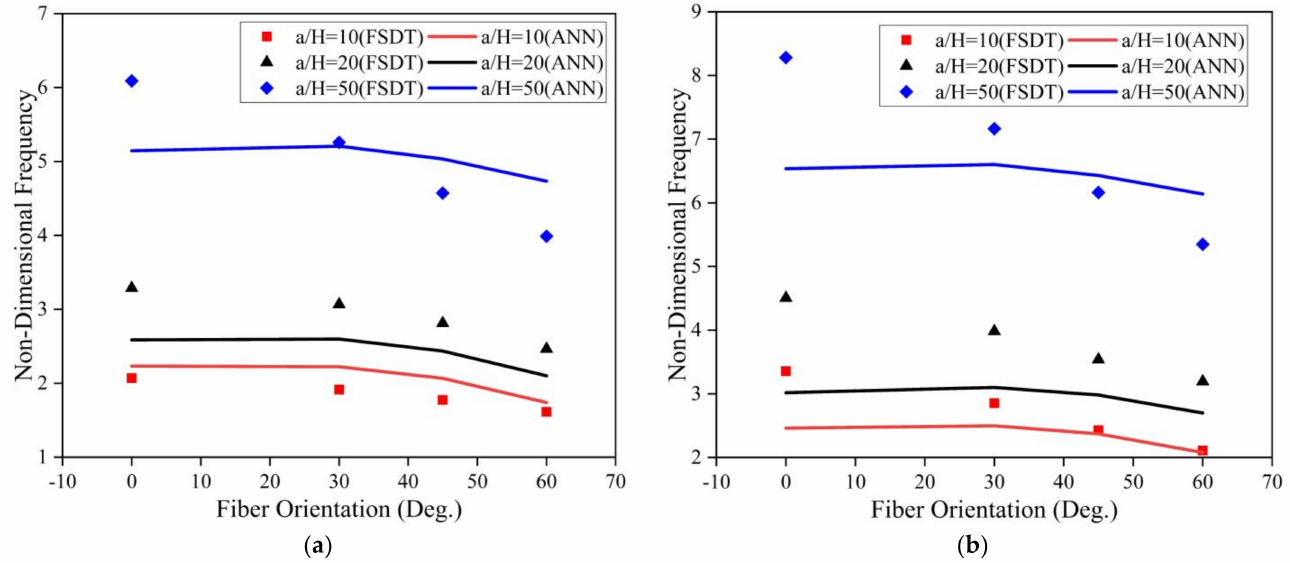
Figure 15. Influence of the face sheet fiber orientation angle on the skew LCS plate in the presence of an elevated thermal environment (375 K) for varying a/H ratios operating under ( a ) SSSS and ( b ) CCCC boundary